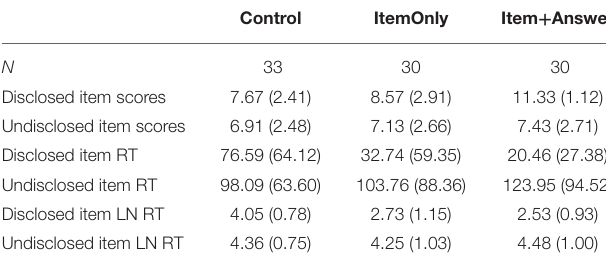
significantly in item scores or log RTs for undisclosed items. TABLE 1 | Descriptive statistics by